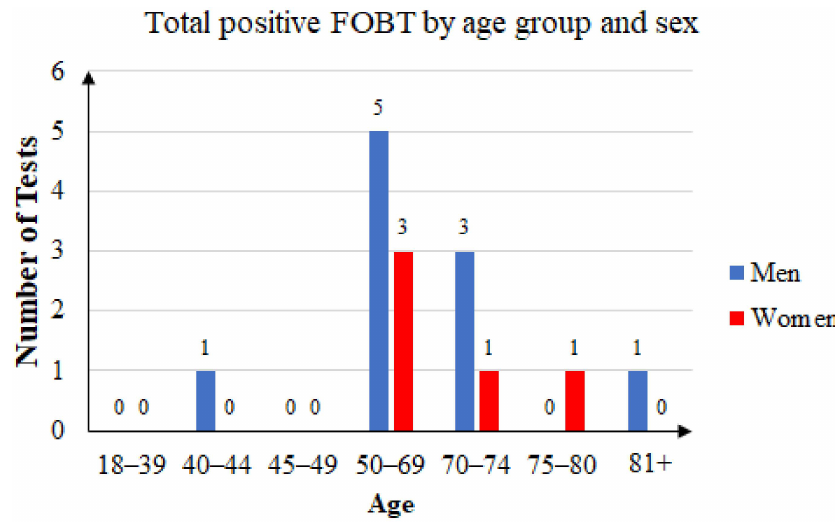
Figure 6. Total positive FOBT by age group and sex.